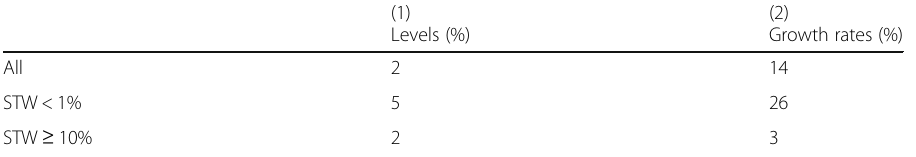
Table 9 Variance decomposition: GVA (impulse): Employment (response) (1) (2) Levels (%) Growth rates (%) All 2 14 STW < 1% 5 26 STW ≥ 10% 2 3 Variance decompositions from PVAR with employment and output (GVA). The first column is a specification in log levels, the second column annual growth rates. The figures are the cumulative percentage of the variation in employment explained by an output shock after 10